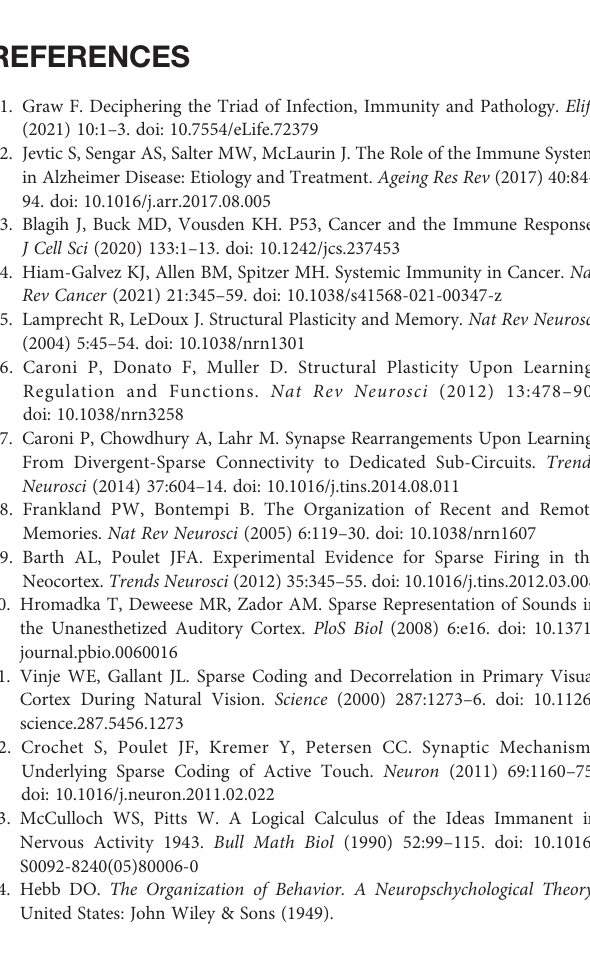
Supplementary Figure1 | Encoded chemosensitive (pCR) network fromtop 200 gene pairs of absolute association scores. Major biological processes from Gene Ontology are highlighted with their respective colors. Supplementary Figure 2 | Encoded chemoresistant (RD) network from top 200 gene pairs of absolute association scores. Major biological processes from Gene Ontology are highlighted with their respective colors. Supplementary Figure 3 | Encoded good prognosis network from top 200 gene pairs of absolute association scores. Major biological processes from Gene Ontology are highlighted with their respective colors. Supplementary Figure 4 | Encoded poor prognosis network from top 200 gene pairs of absolute association scores. Major biological processes from Gene Ontology are highlighted with their respective colors. Supplementary Figure 5 | Common network modules for encoded chemosensitive and chemoresistant networks. Modules are named based on their respective hub genes. Chemosensitive modules are shown with nodes of green borders and chemoresistant modules are shown with nodes of grey borders. Red edges between nodes indicate the positive cumulative association weights. Direction of arrows shown in the edges indicates predictability of a gene to